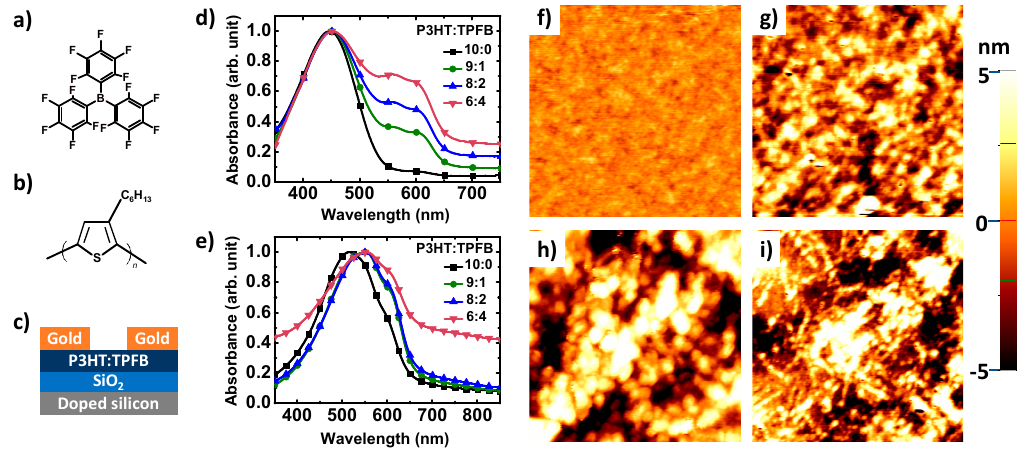
Figure 1. ( a,b ) Chemical structures of ( a ) tris(pentafluorophenyl)borane (TPFB) and ( b ) regioregular poly(3-hexylthiophene) (P3HT). ( c ) Schematic of the organic transistor-based sensor. ( d,e ) UV-vis absorption spectra of the blends: ( d ) in solutions (5 mg/L in chloroform) and ( e ) in thin films with different P3HT:TPFB ratios. ( f–i ) AFM surface topographic images of thin films: ( f ) pure P3HT, ( g ) P3HT:TPFB (9:1), ( h ) P3HT:TPFB (8:2), and ( i ) P3HT:TPFB (6:4). The image size is 2 µm by 2 µm.